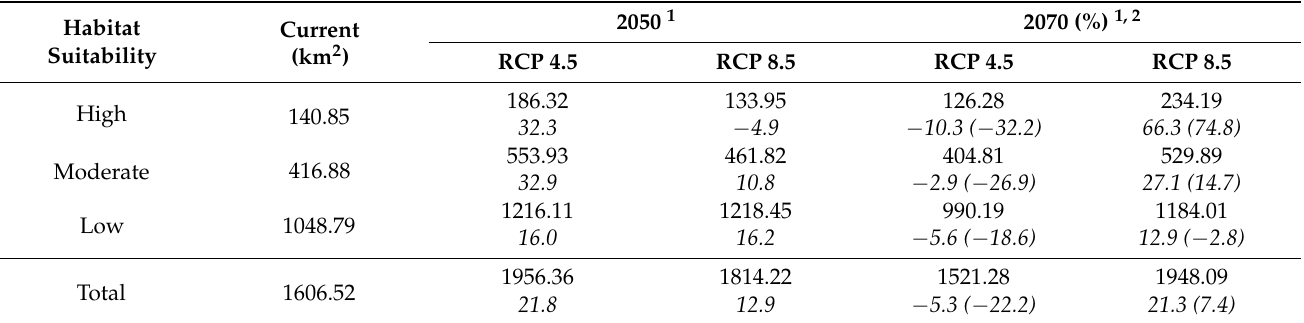
Table 1. Area (km 2 ) of predicted potential distribution under current conditions and variation (%) of X. loweryi in Amazonas and San Martin (Peru) under climate change